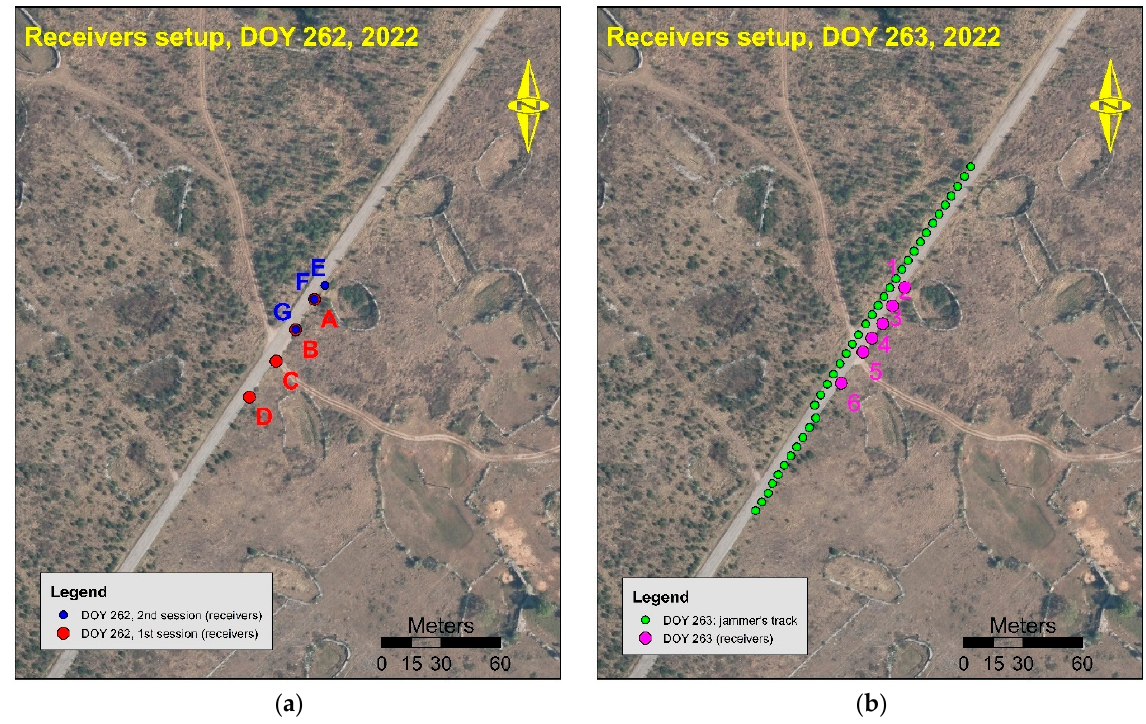
Figure 5. Test site in Č rnoti č e, Slovenia: ( a ) the two-sessions experiments from DOY 262; and ( b ) experiments from the DOY 263 with jammer’s track in walking scenario.